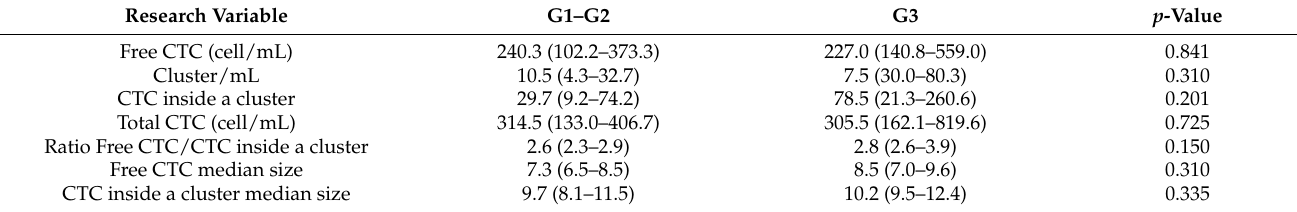
Table 3. Correlation CTC and clusters according to the degree of tumor differentiation (PV